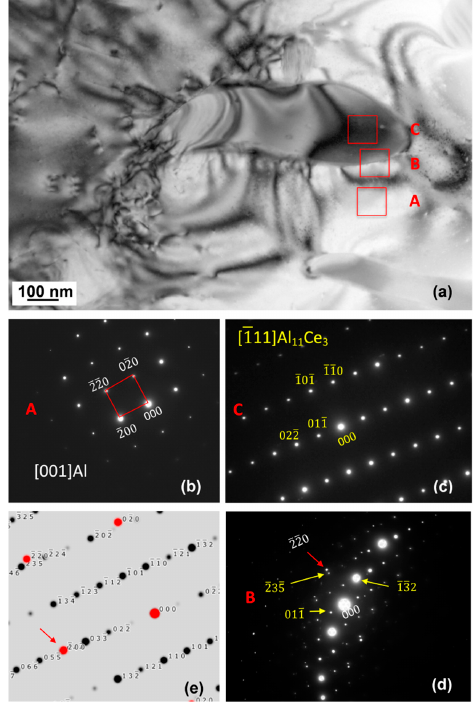
Figure 14. TEM bright field image ( a ) and SAD patterns of the eutectic phases at the early growth stage: Al ( b ); Al 11 Ce 3 ( c ); interface region ( d ); simulated diffraction pattern from the interface ( e ).